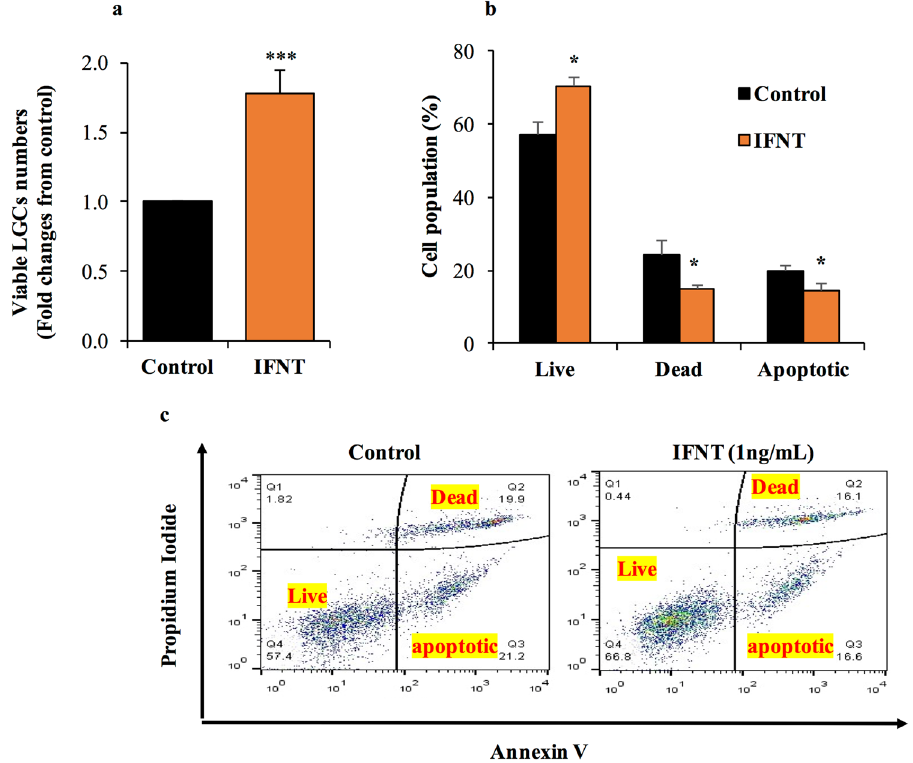
Figure 2. IFNT increased LGCs viability and reduced apoptosis. ( a ) Cells were assayed with XTT 48 h after treatment with 1 ng/mL of roIFNT. ( b ) Cells were treated with 1 ng/mL of roIFNT and analyzed using FACS with propidium iodide and Annexin V staining (representative plots). ( c ) Quantification of FACS results. Asterisk indicate significant ( * P < 0.05) difference from cells treated in basal media (control).